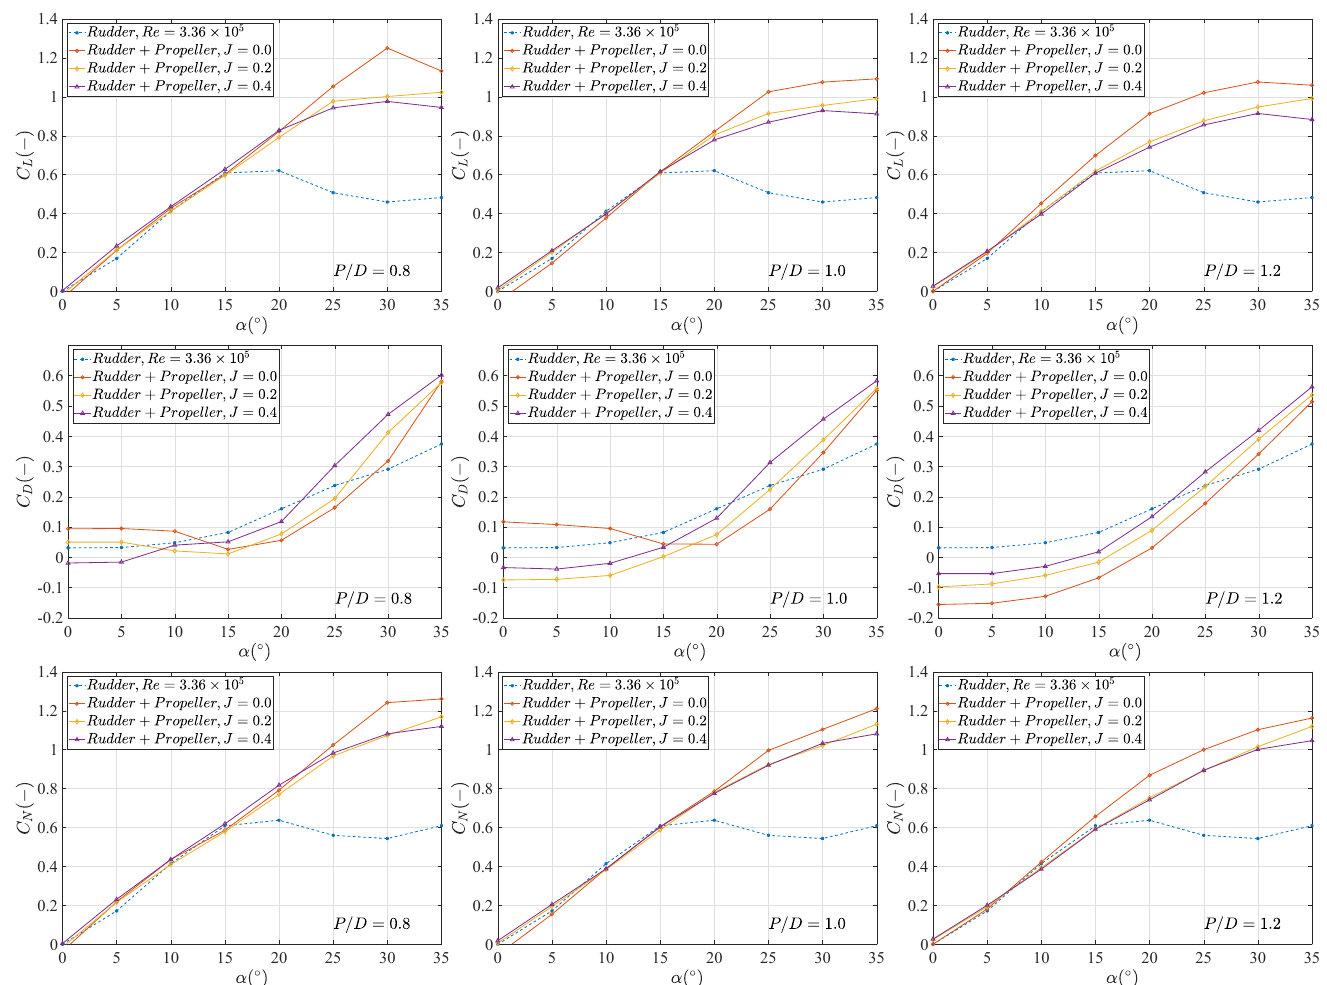
Figure 1. Comparison of the hydrodynamic coefficients of a rudder in open water conditions to those of the rudder in propeller slipstream. Data are adopted from Nienhuis